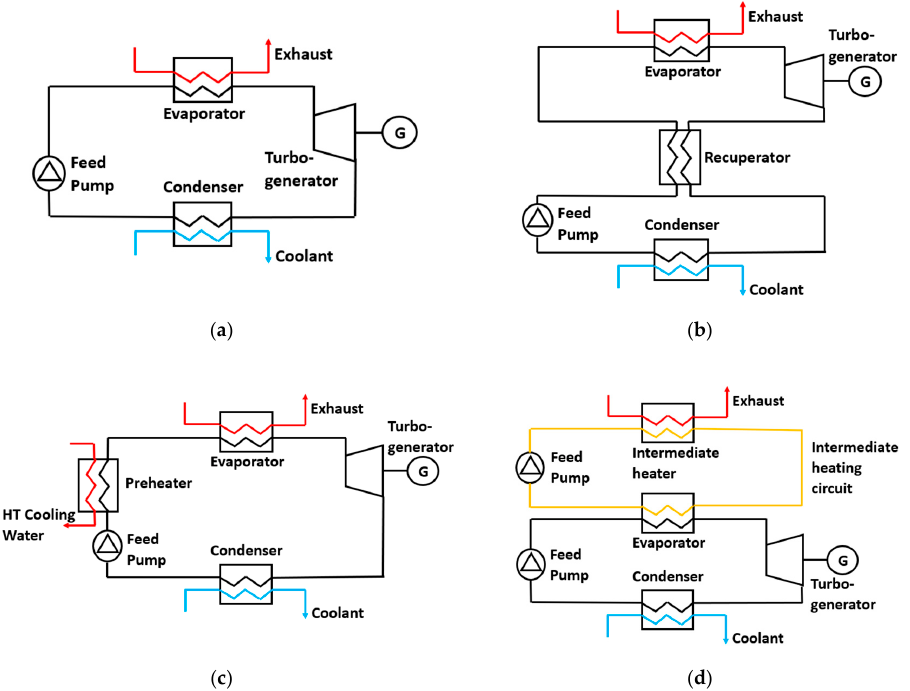
Figure 3. ORC basic cycle configurations: ( a ) Simple ORC (sORC); ( b ) Recuperative ORC (rORC); ( c ) Simple with dual heat source ORC (sdhORC); ( d ) Simple ORC with intermediate heating (sORC/ih).